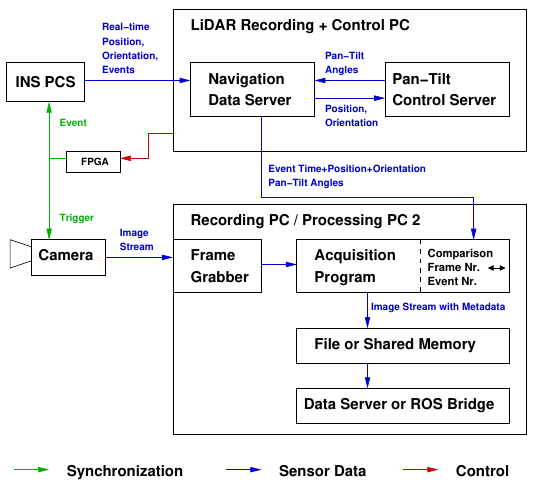
Figure 3. Schematic of data acquisition from cameras and embedding of metadata into image streams. The navigation data server interpolates the position and orientation to the event (trigger) times. See text for